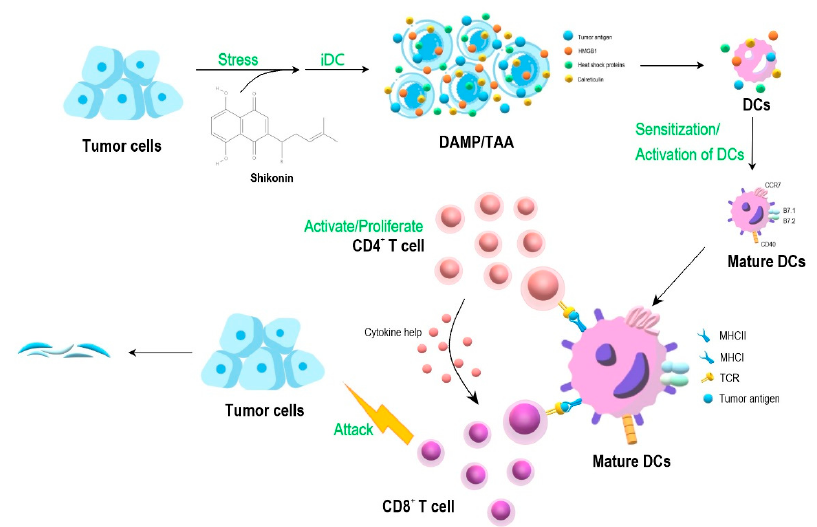
Figure 1. A DC-based cancer vaccine approach. Effect of shikonin-induced ICD in tumor cells for activation of DCs, resulting in T cell activation and enhanced attack tumor cells. Abbreviations: DAMP, danger associated molecular patterns; TAA, tumor associated antigens; TCR, tumor cell receptor; CD4 + T, CD4 + type thymocyte cells.